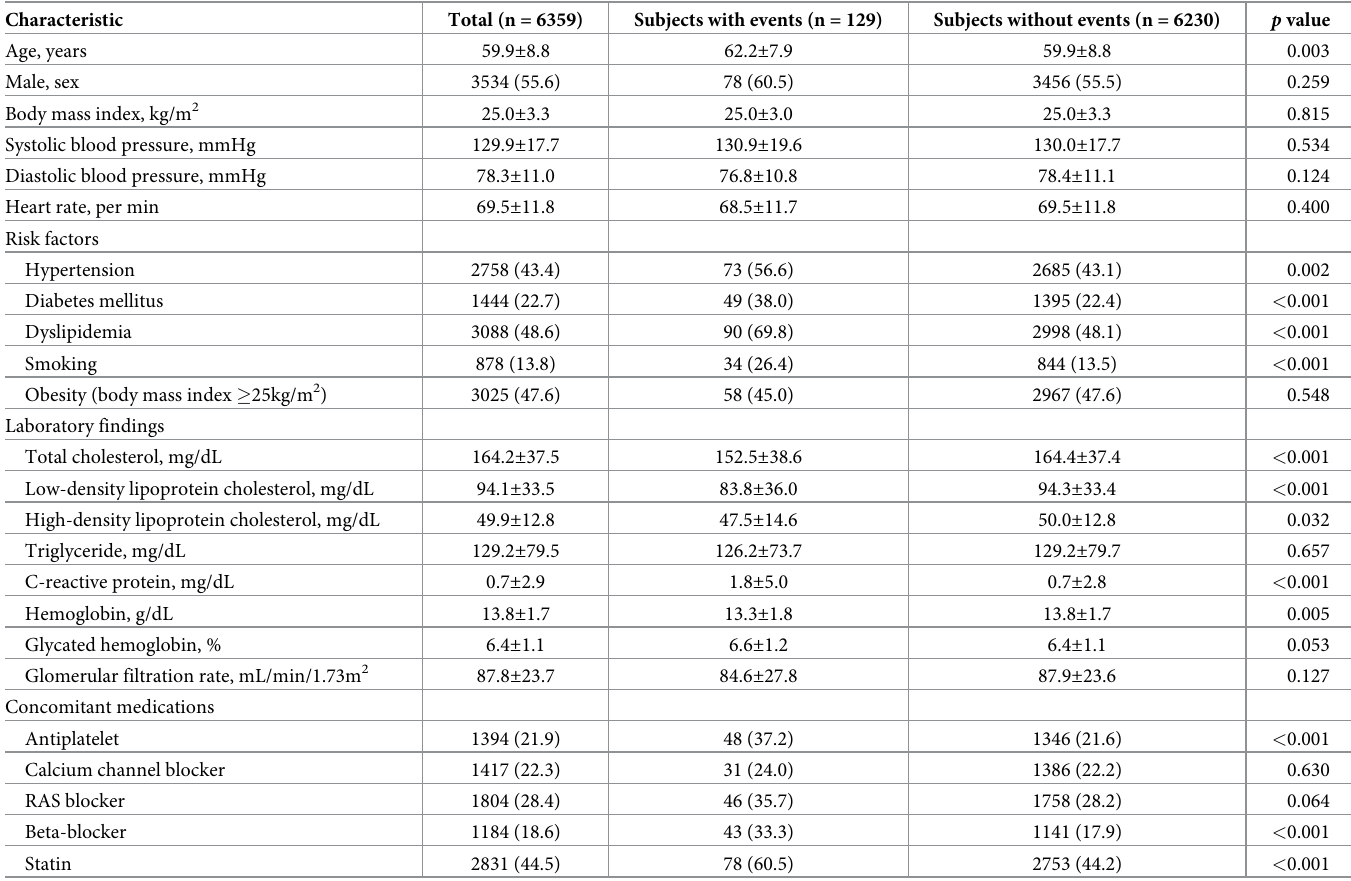
Table 1. Baseline characteristics of study